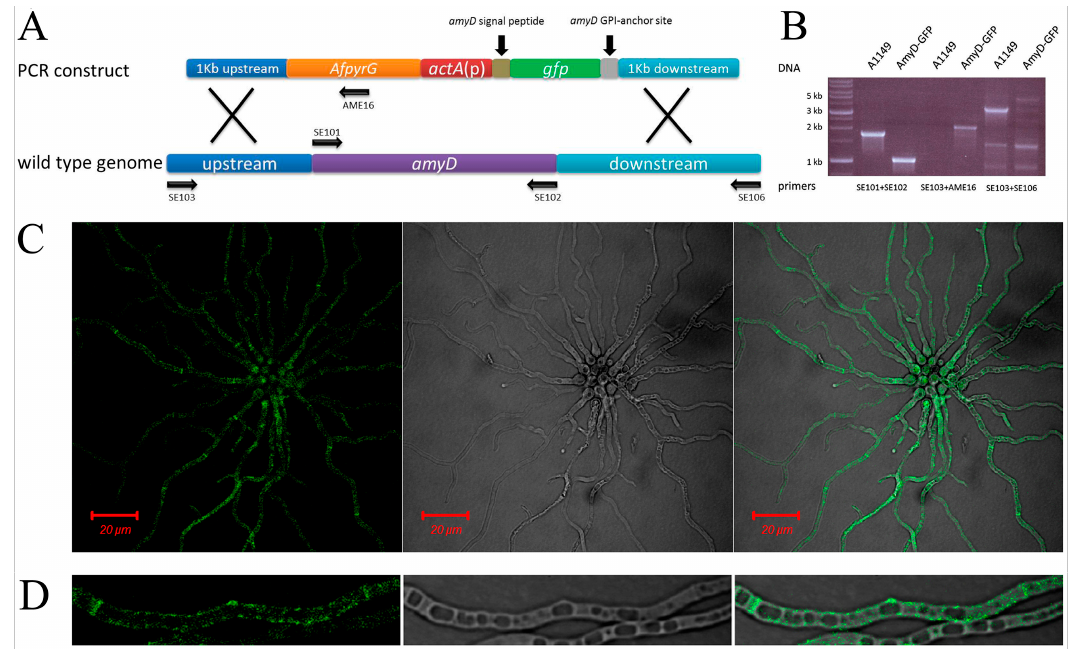
Figure 1. Localization of AmyD associates with cell membrane; ( A ) Strategy of chimera-AmyD-GFP strain construction. The amylase-like domain of AmyD was replaced by a GFP, whereas the localization determining elements of AmyD were maintained. The localization of AmyD corresponded to a chimera-GFP signal; ( B ) PCR verification of AmyD-GFP strain. Primers targeting sites were labeled in ( A ). PCR using SE101 + SE102 primers confirmed the replacement of amyD by gfp . PCR using SE103 + AME16 and SE103 + SE106 primers confirmed the integration of the construct at the designed place. No ectopic insertion was found in the AmyD-GFP genome; ( C ) the GFP signal was examined using a Zeiss META501 confocal epifluorescence microscope at 63 × NA 1.2 or 25 × N.A. 1.0 objective lens. Confocal imaging used 488 nm excitation with emission controlled by a BP 505–530 nm filter; and ( D ) a magnified hypha image showed the GFP signal strongly associated with septa and the cell